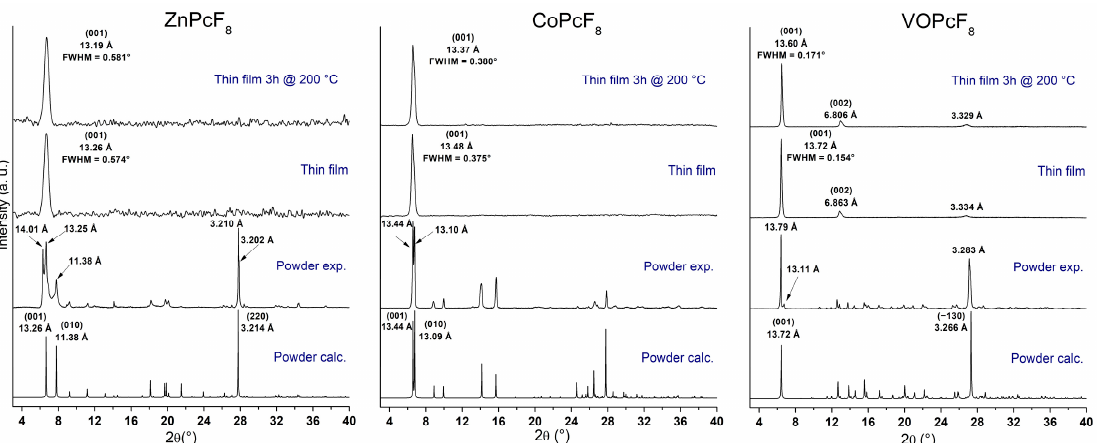
Figure 7. XRD patterns for MPcF 8 powders (experimental and calculated) and thin films before and after heating for 3 h at 200 °C.